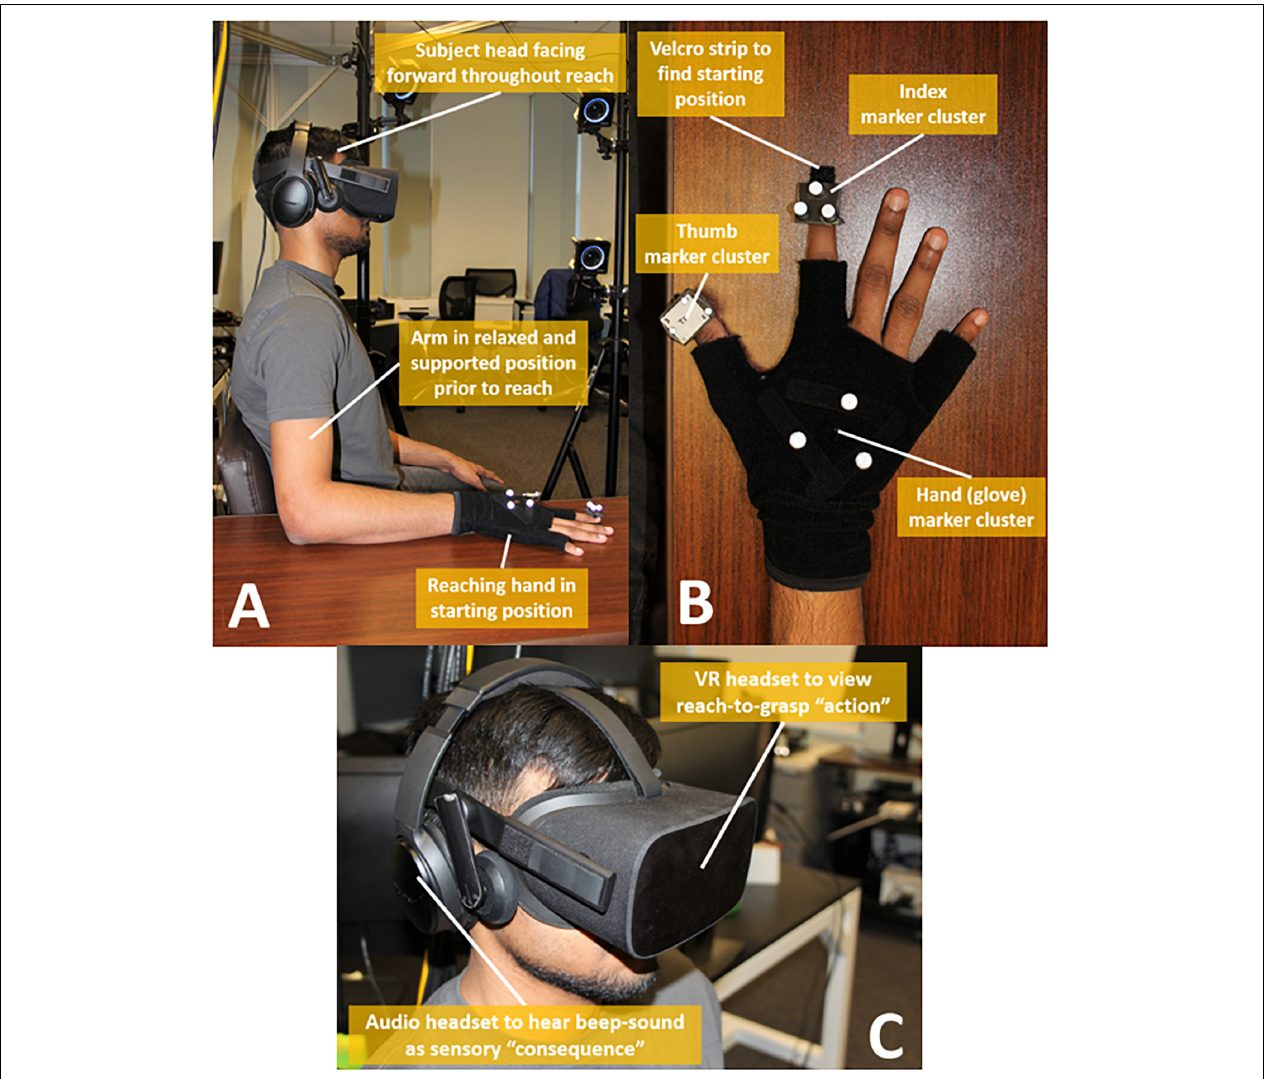
FIGURE 2 | Experimental set-up elements. (A) Participant positions body and arm at start of each trial, (B) Hand shown with motion capture marker clusters, (C) Participant head mounted with VR headset and audio